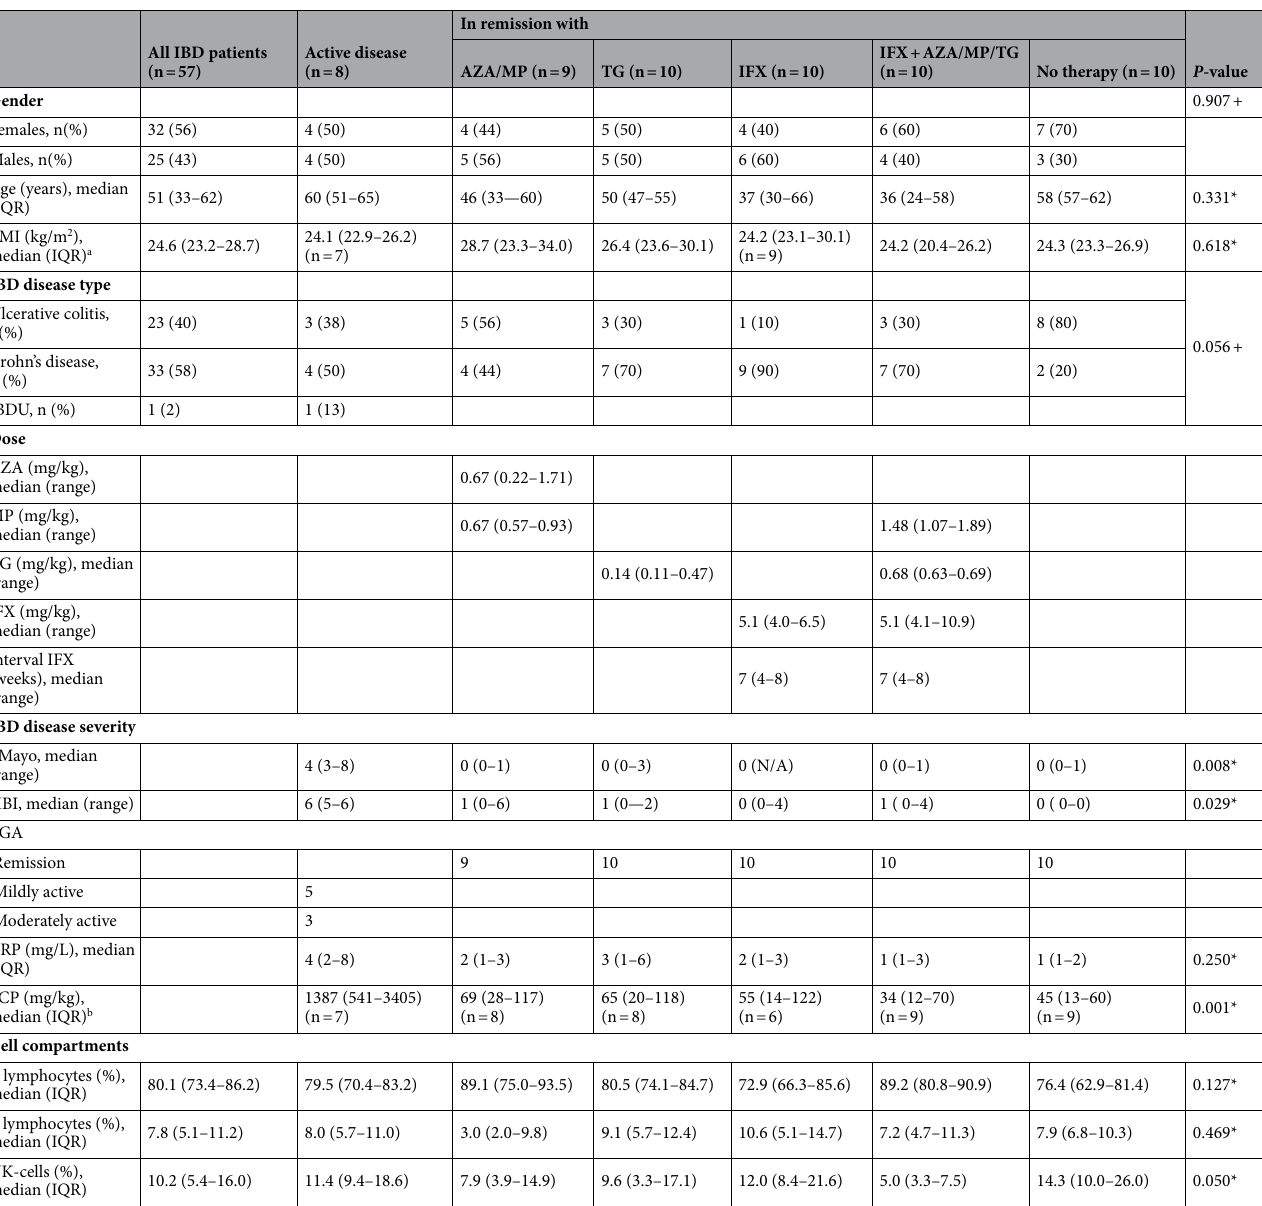
Table 1. Patient characteristics. BMI body mass index, IBD inflammatory bowel disease, IBD-U IBD- unclassified, AZA azathioprine, MP mercaptopurine, TG tioguanine, IFX infliximab, HBI Harvey